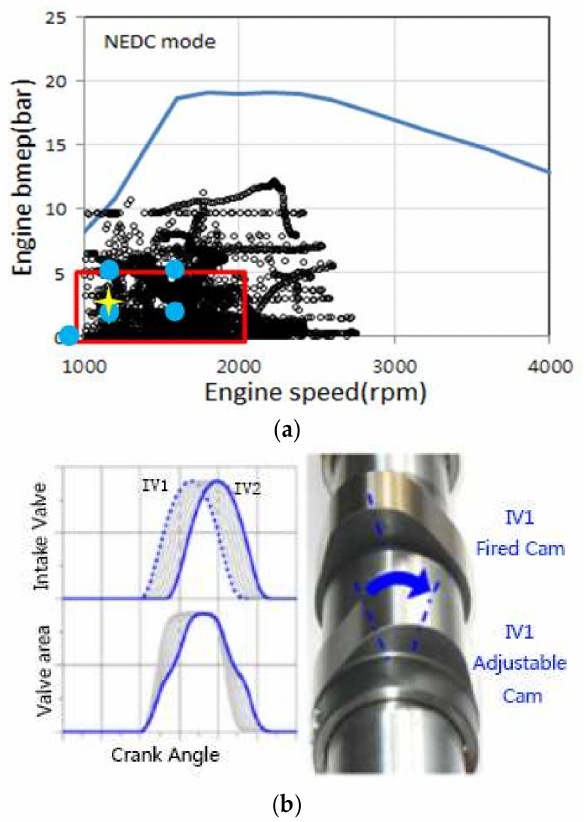
Figure 1. Engine map and variable valve device. ( a ) Five operating points on map in R-engine; ( b ) Prototype cam-in-cam system